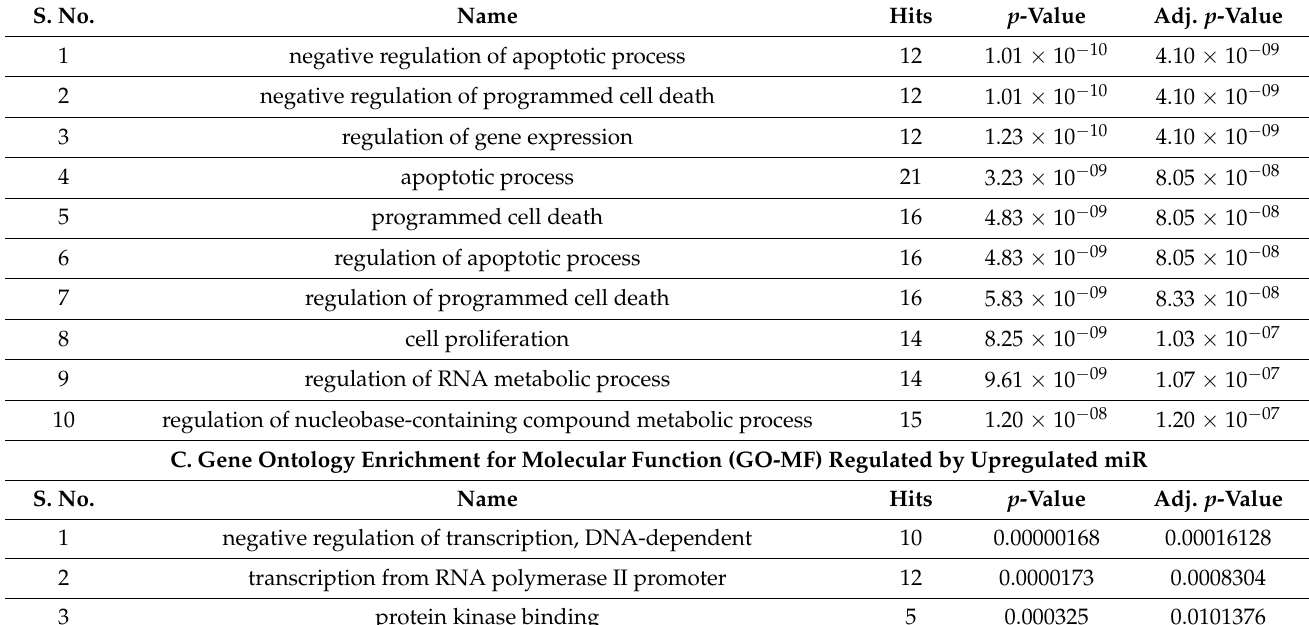
B. Gene Ontology Enrichment for Biological Process (GO-BP) Regulated by Upregulated